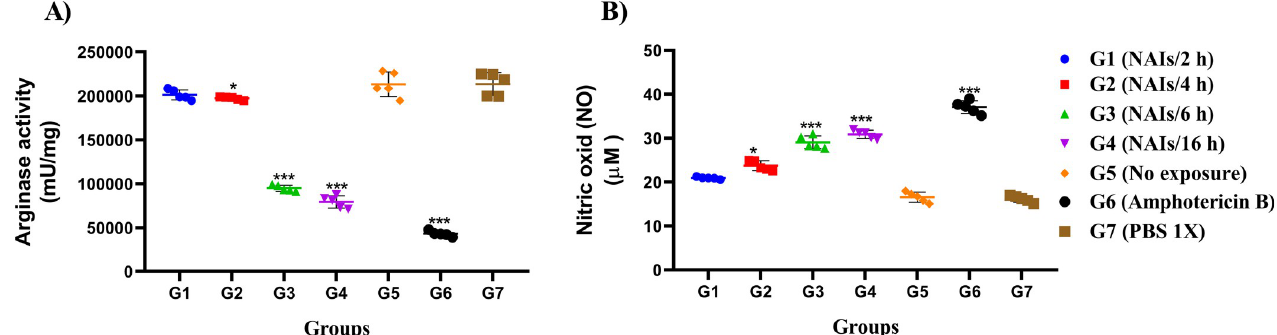
Fig 6. Arginase activity and nitric oxide (NO) production in L . major infected BALB/c mice undergoing NAIs therapy. Arginase activity (mU/mg) (A) and NO production ( μ M) (B) were assessed by using microplate method and Griess assay, respectively (after the end of treatment, five mice from each group were randomly selected). All data are shown as the mean ± SD, five mice per group. The data shown are from one representative out of three independent experiments with similar outcomes ( � P < 0.05, �� P < 0.01, ��� P < 0.001).